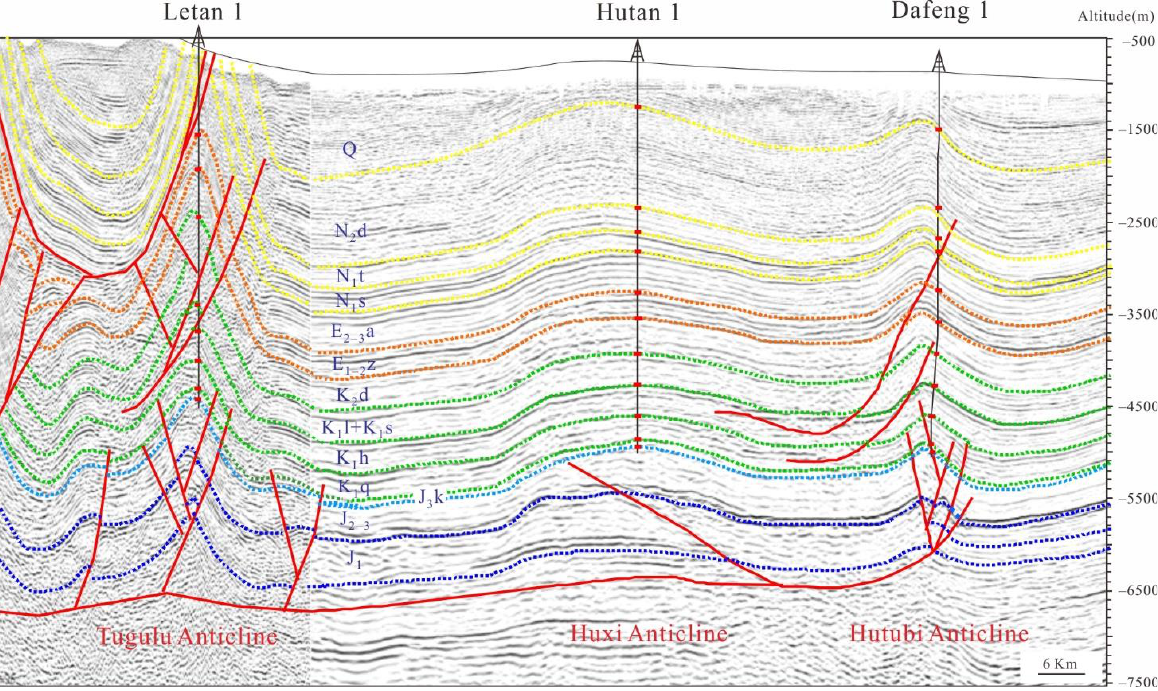
Figure 5. Tectonic style section in southern Junggar